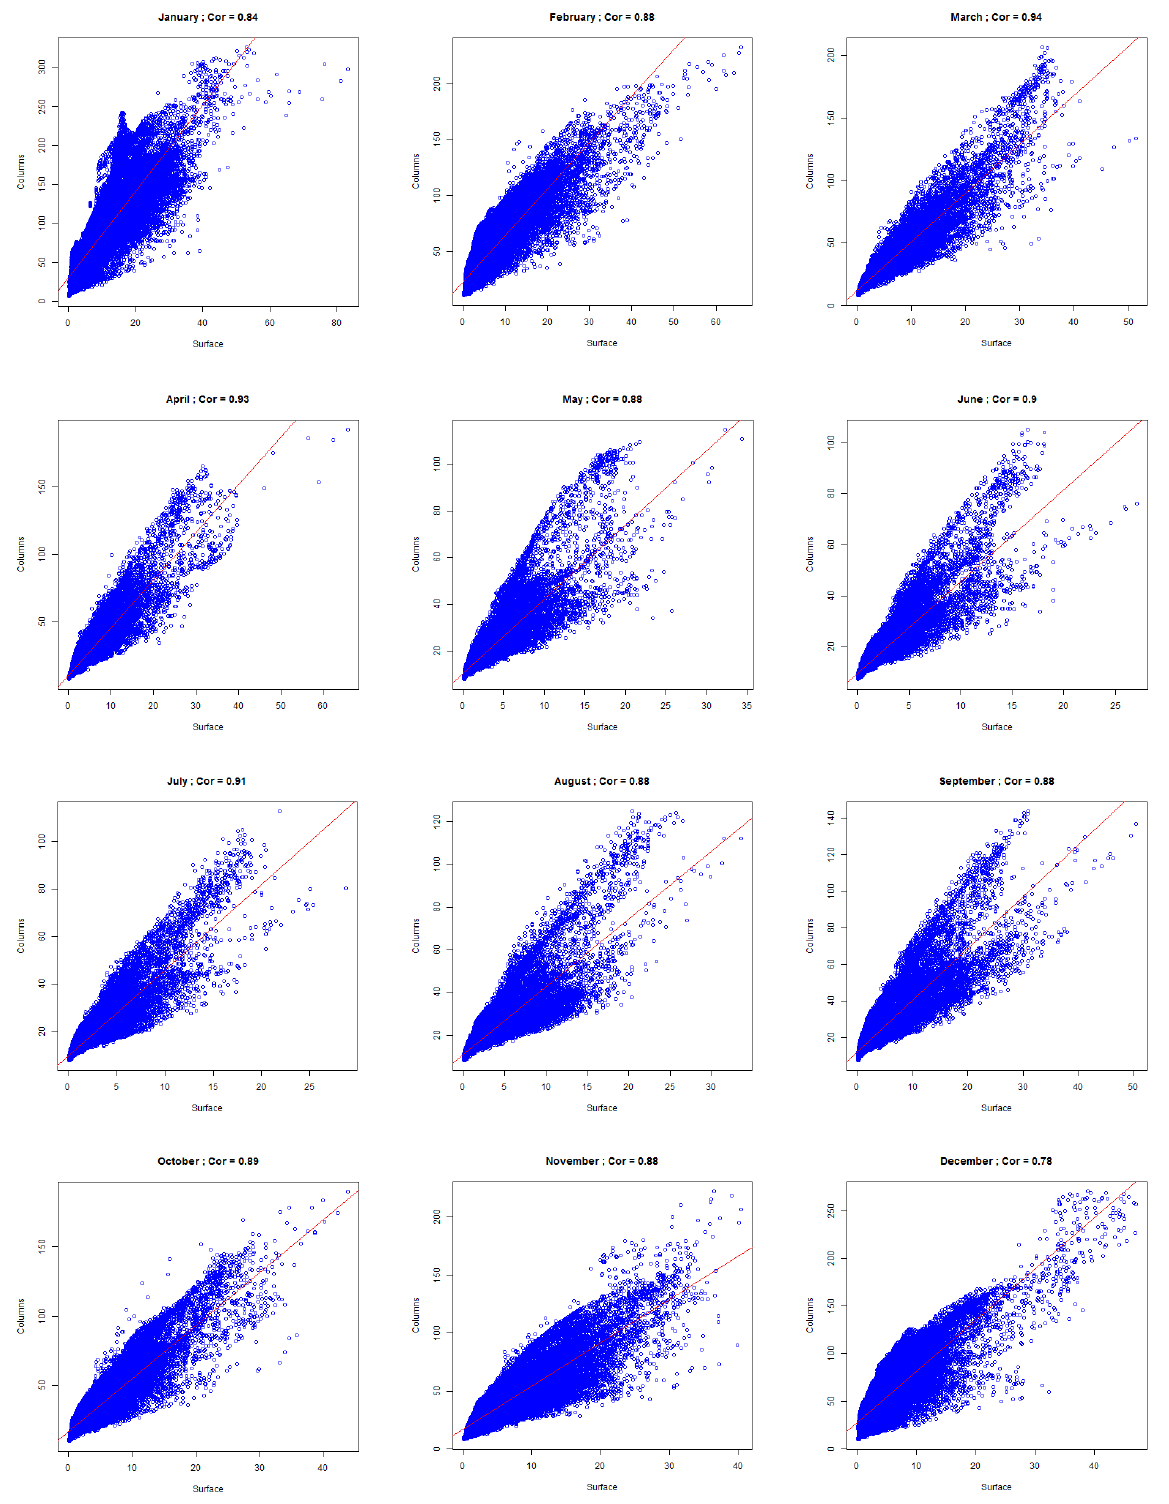
Figure 11. Relation between NO 2 tropospheric columns (Y axis) and surface concentrations NO 2 (X axis) from the GEM-AQ model (single point represent one grid point).